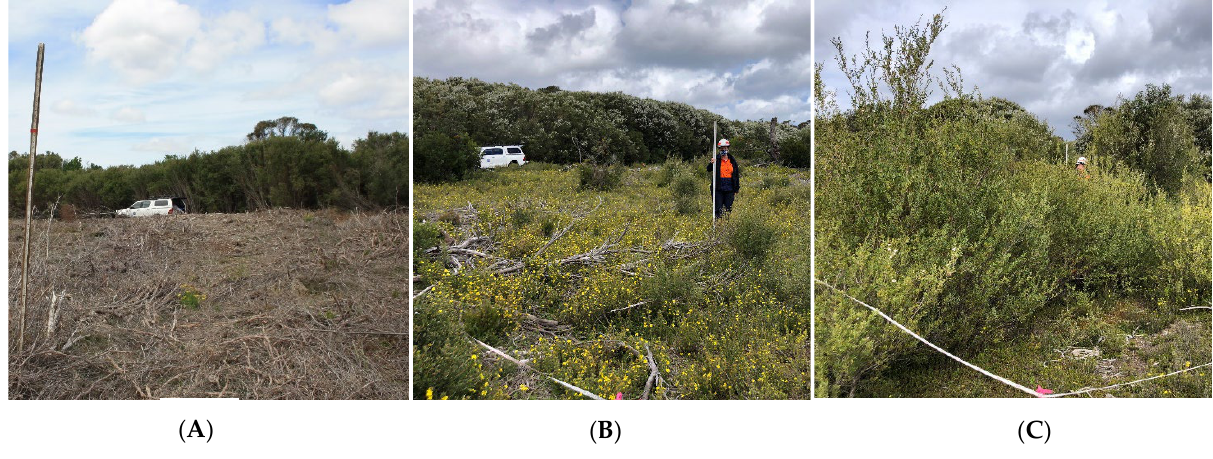
Figure 2. Image of post-masticated sites in Wilsons Promontory National Park, Victoria after; ( A ) 6 months, ( B ) 2.4 years, and ( C ) 8.8 years. The foreground depicts a masticated site whilst the background shows a dense thicket of Leptospermum laevigatum (a native shrub-encroaching species) in an un-masticated area. Height pole is 2 m in height.